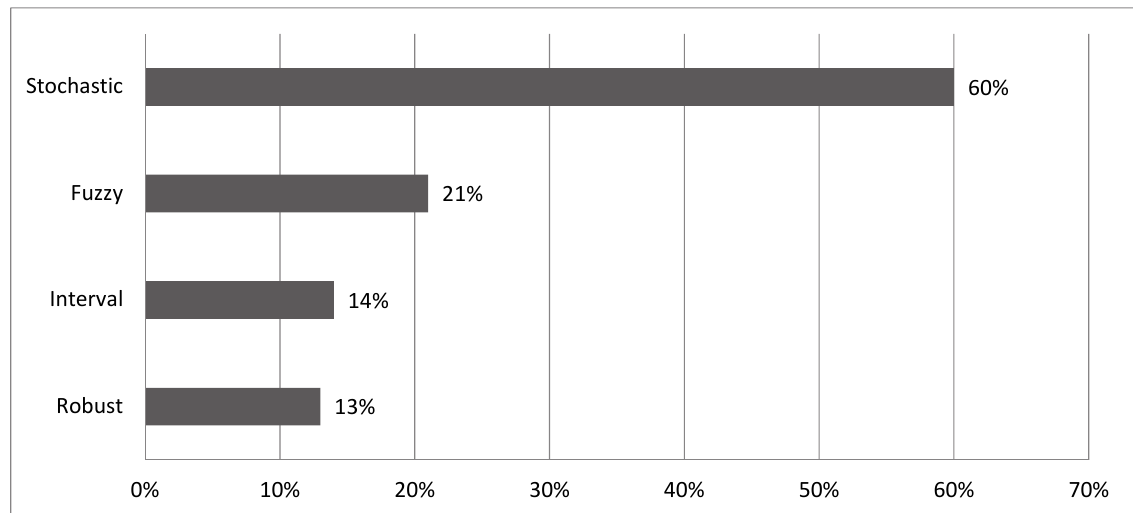
Fig. 4. Distribution of solution approach to deal with uncertainty